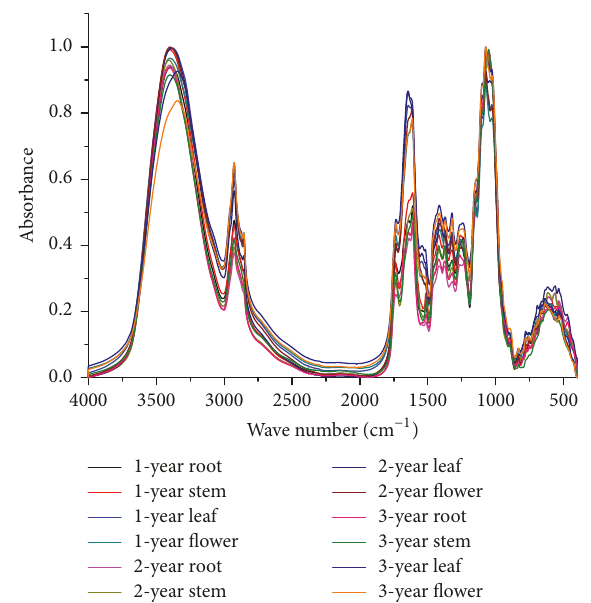
Figure 4: The original FTIR spectra of G. rigescens samples. (Description: this figure shows the original FTIR spectra of G. rigescens samples from different organs and cultivation ages. These spectra are exhibited as mean